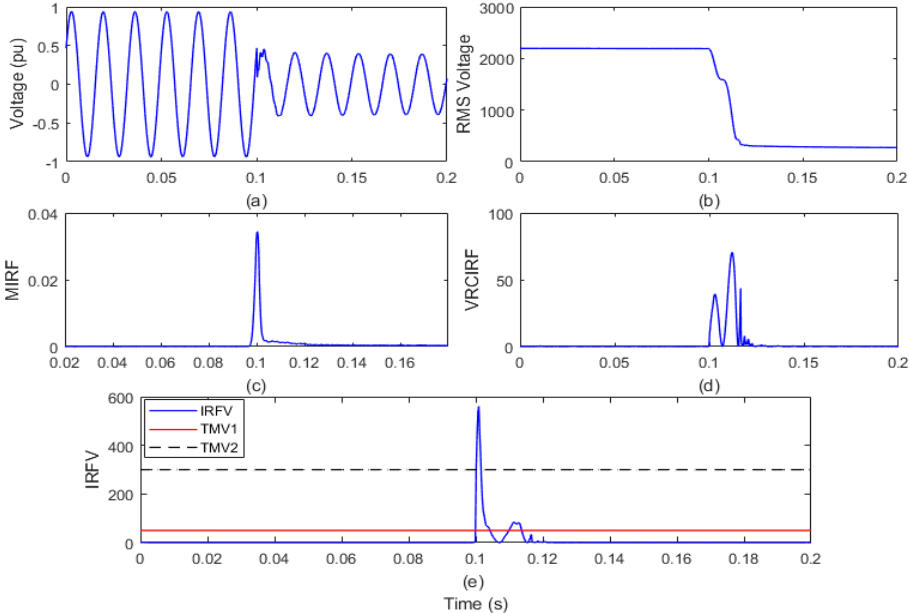
Figure 9. Two-phase-to-ground fault ( a ) voltage signal ( b ) root means square value of voltage ( c ) median-based IRF ( d ) rate of change in voltage-based IRF ( e ) islanding recognition factor based on voltage.